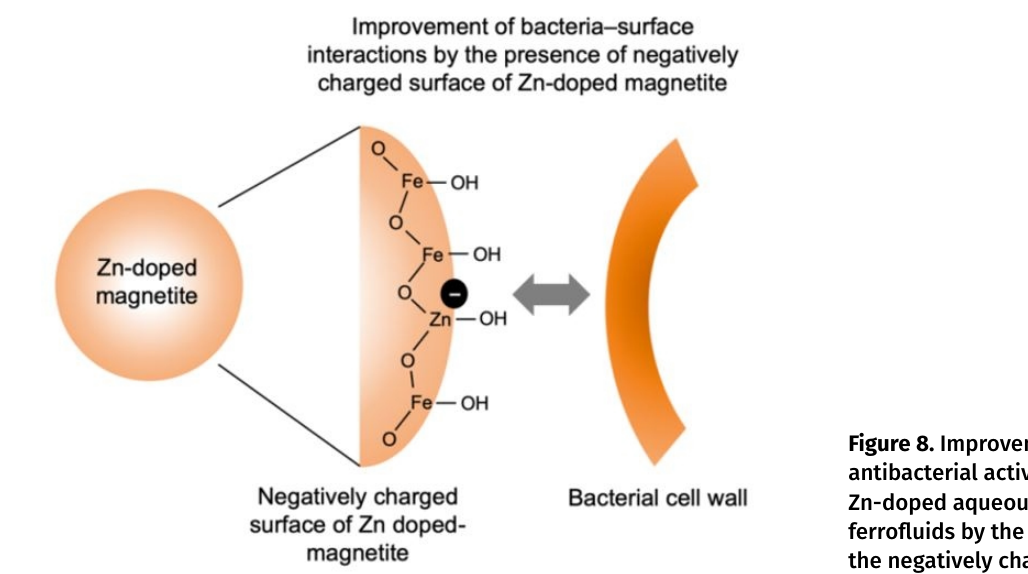
Figure 8. Improvement of antibacterial activity of the Zn-doped aqueous magnetite ferrofluids by the presence of the negatively charged